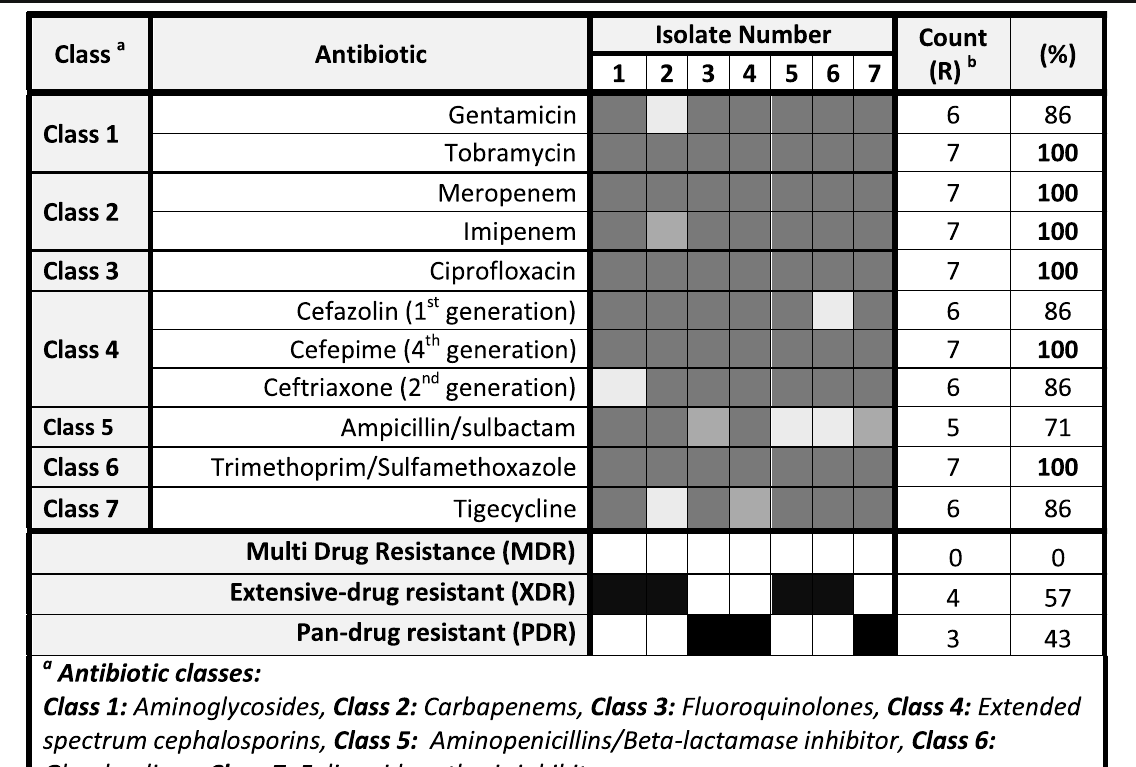
Table 4 Antibiotic resistance pattern among the different Acinetobacter